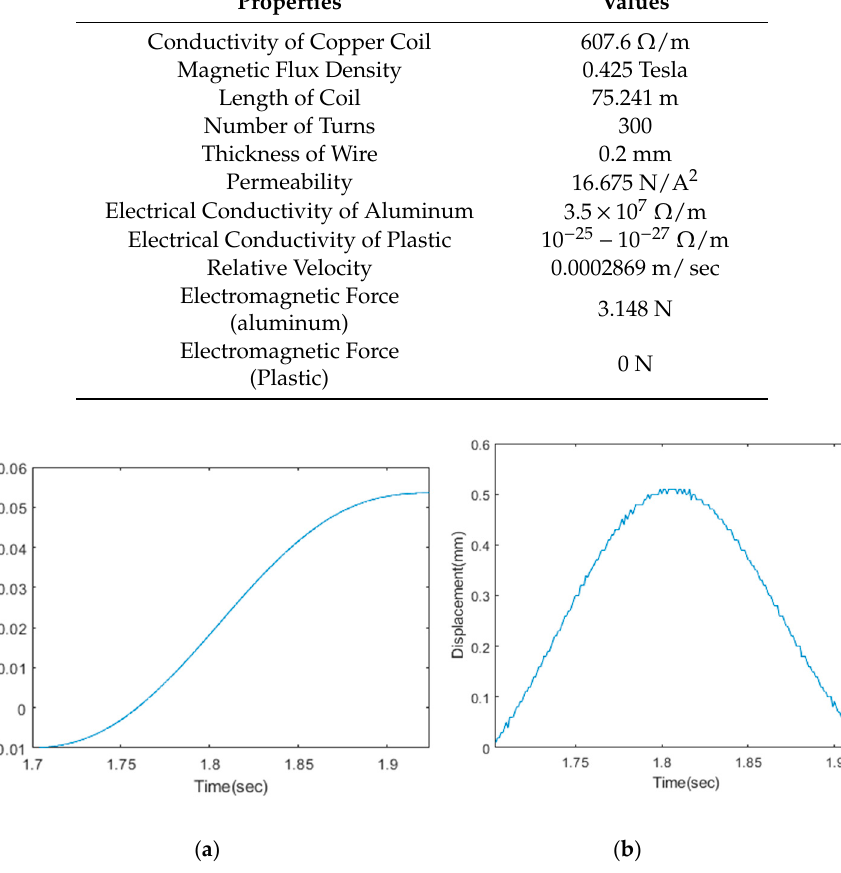
Figure 22. (a) Displacement according to step input and (b) instantaneous velocity according to Figure 22. ( a ) Displacement according to step input and ( b ) instantaneous velocity according displacement. to Table 6. Electromagnetic damping force for two different materials.